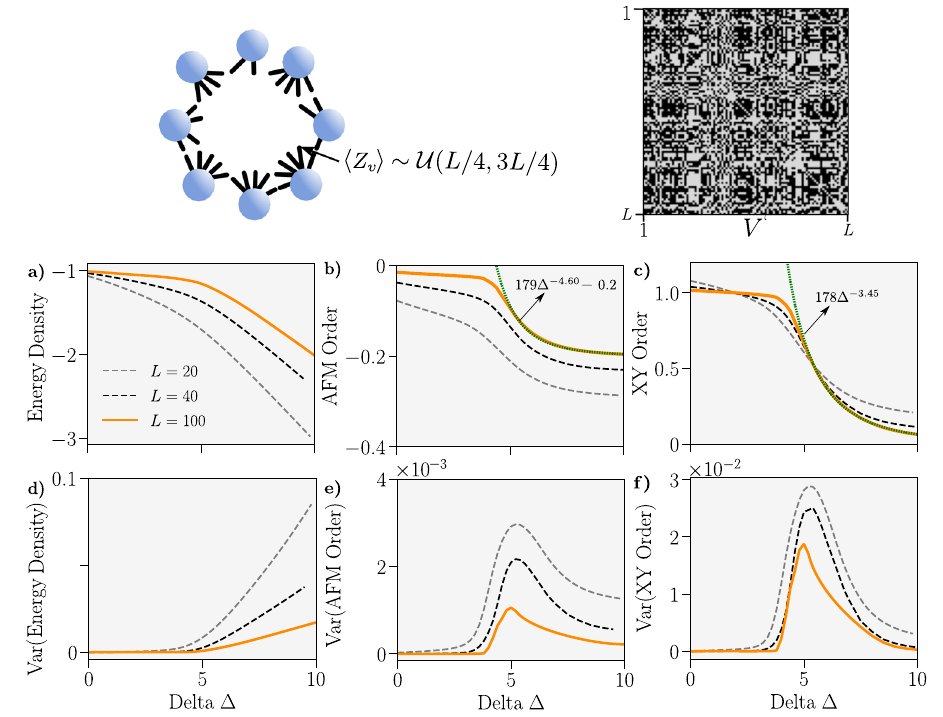
Fig. 4 | Properties of the ground-state of the spin 1/2 XXZ Hamiltonian on the graph where each site has a degree Z V drawn from U ð L = 4 , 3 L = 4 Þ , the uniform discrete distribution over the interval [ L /4,3 L /4]. Graph schematic alongside adjacency matrix for L =100 is provided. a – c Average energy density, anti-